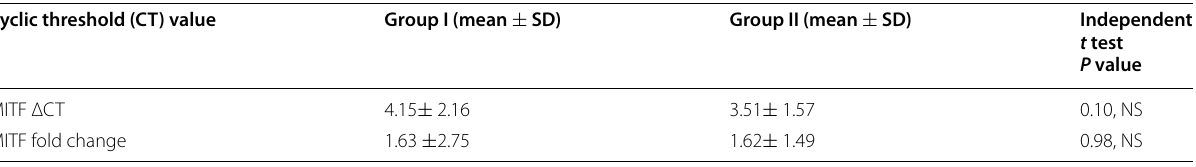
P value>0.01, NS - not statistically significant